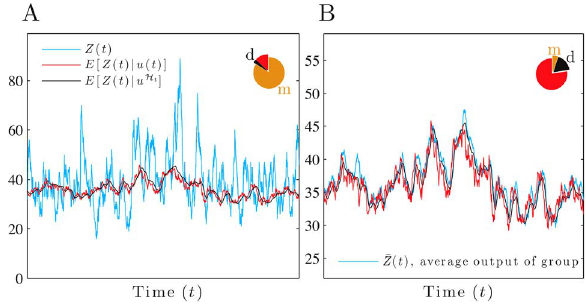
Figure 5. The fidelity of the collective response of a group of cells exceeds that of a single cell. We consider a 2-stage model of gene expression with the signal of interest s ( t ) ~ u ( t ) , and with u ( t ) proportional to the level of a transcriptional activator and modeled as an Ornstein-Uhlenbeck process. The unconditional distribution of u ( t ) is therefore Gaussian. Pie charts show fractions of the protein variance due to the mechanistic (m) and dynamical (d) errors and are computed using our Langevin method (SI). (A) For a single cell with negative autoregulation ( K 1 ~ 1 ), fidelity is low and equal to 0.2, with a dominant mechanistic error. (B) For 100 identical and independent cells (given the input’s history), with negative autoregulation ( K 1 ~ 1 ): fidelity between u ( t ) and the average protein output for the group is higher and equal